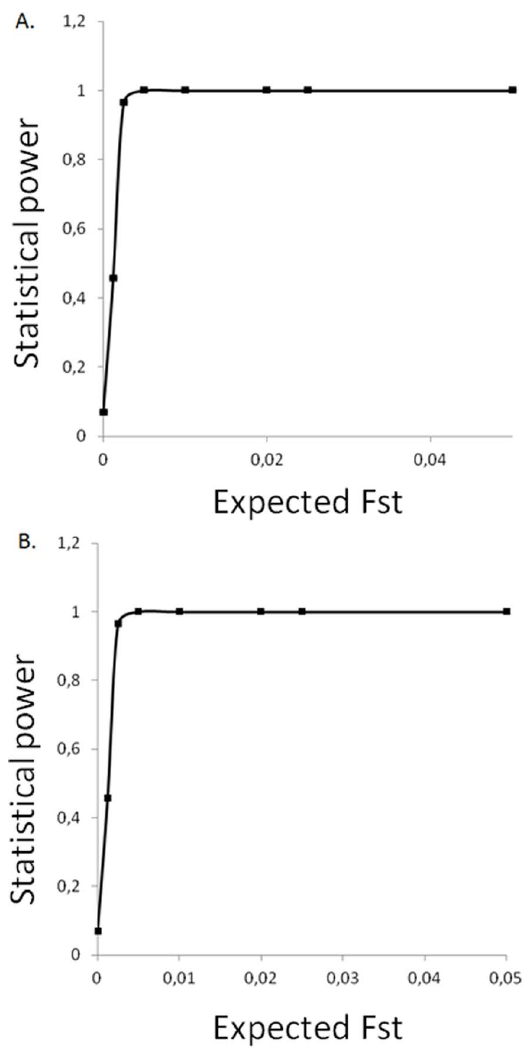
Figure 2. Statistical power in detection of significant genetic differentiation. Statistical power is given as calculated by P OWSIM 4.1 (Ryman and Palm 2006). A. Simulated sampling of Ne=1000 into six populations reflecting sample sizes of A VCG , A PVS , P VCG , P PVS , M Bou , M Puy sampling groups. B. Simulated sampling of Ne=1000 into three populations reflecting sample sizes of A, P and M overwintering strategies.